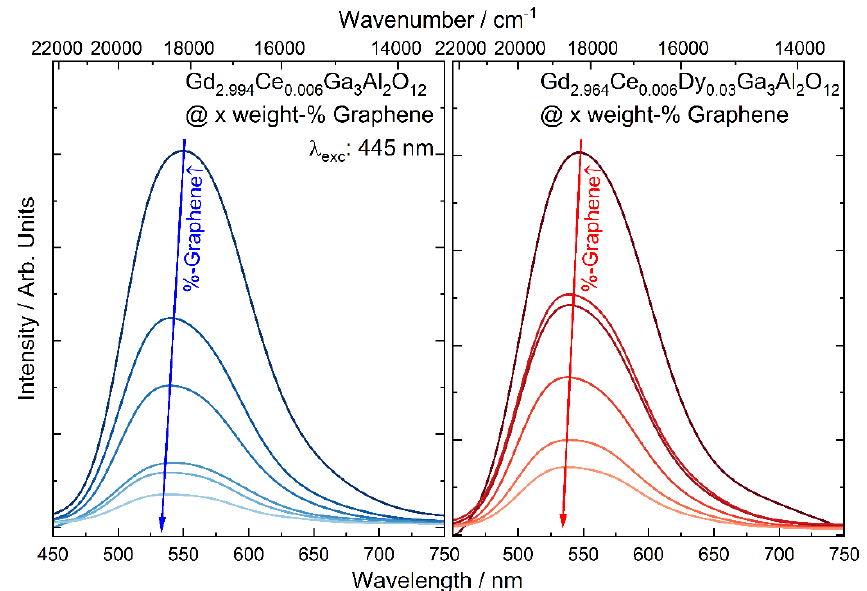
Figure 5. The emission spectra of Gd 2.994 Ce 0.006 Ga 3 Al 2 O 12 and Gd 2.964 Ce 0.006 Dy 0.03 Ga 3 Al 2 O 12 ceramics with different graphene content.